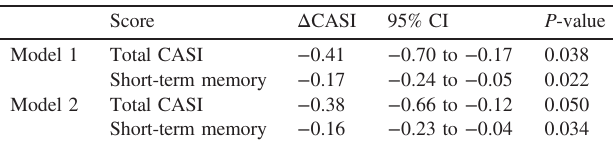
Table 4. Estimated di ff erence in total and domain CASI scores per 1mmol / L higher fasting blood glucose from